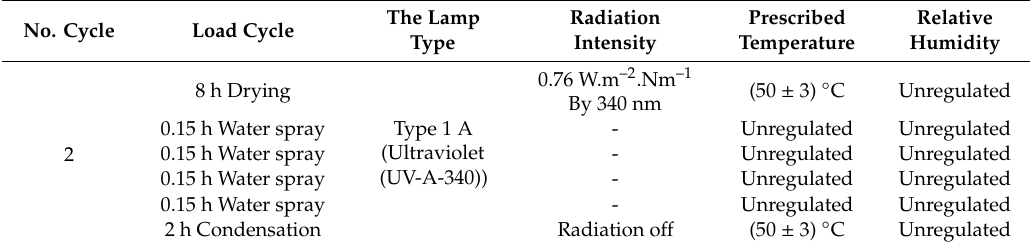
Table 3. Measurement